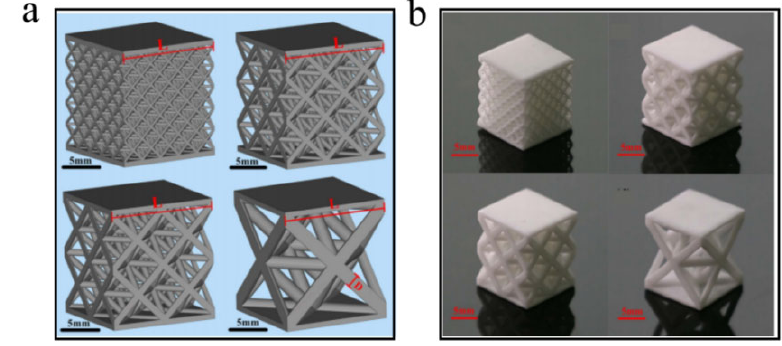
Fig. 44 (a) 3D models with different structures; (b) ZrO 2 ceramic 3D octet-truss structures. Reproduced with permission from Ref. [120], © The Author(s)